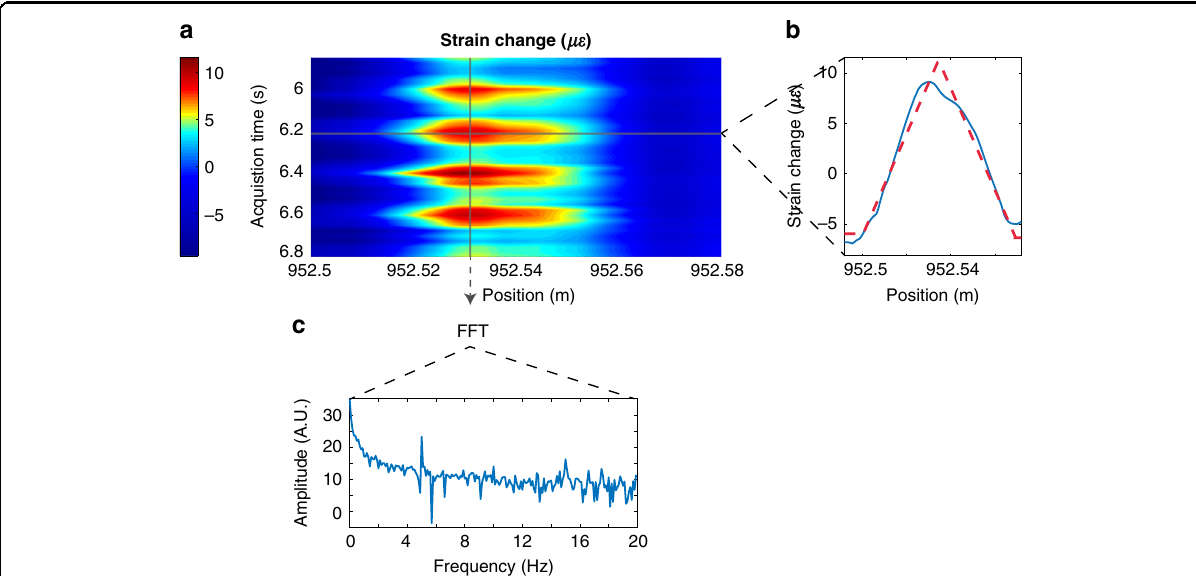
Fig. 5 Strain sensing using the QIR-DFC technique over a 1 km fi bre. a Dynamic stress map around the perturbed area. b Stress pro fi le experimentally obtained at a particular instant of time. As in the case of the results obtained for temperature sensing, the observed distribution is the result of convolving the applied stress distribution by a rectangular resolution window, leading to a roughly triangular-shaped pro fi le. c Amplitude of the Fourier transform of a vertical pro fi le in a located at 952.53